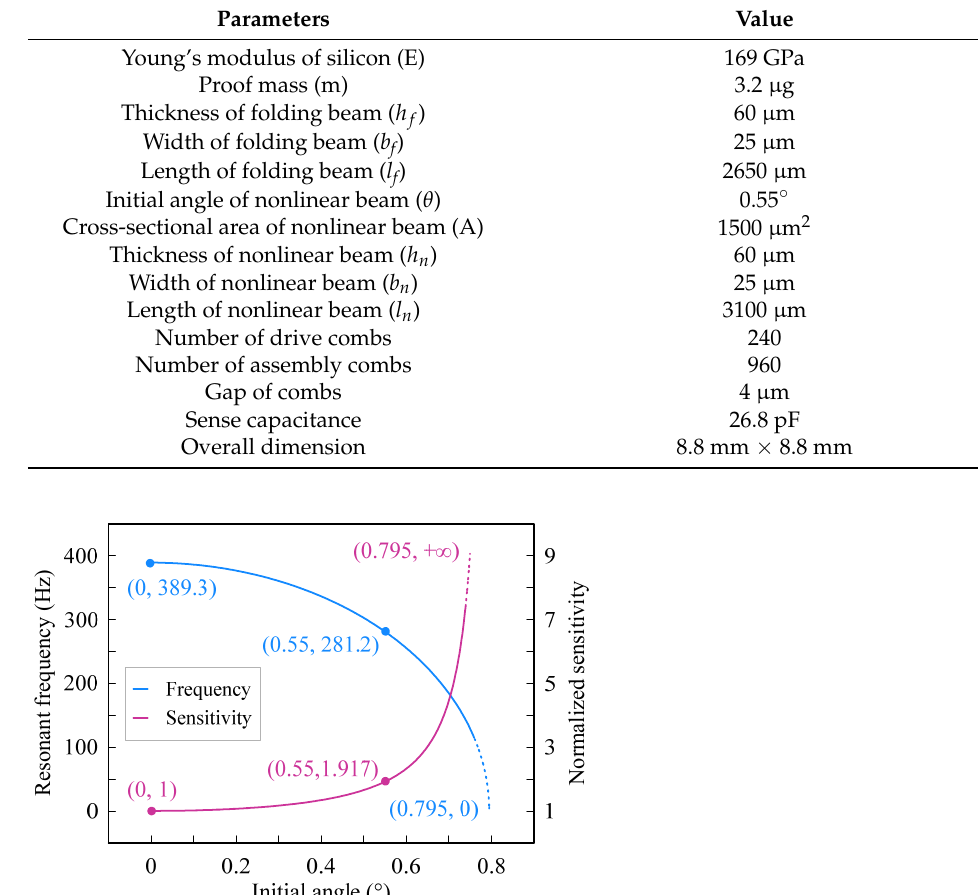
Table 1. Parameters of the proposed accelerometer.